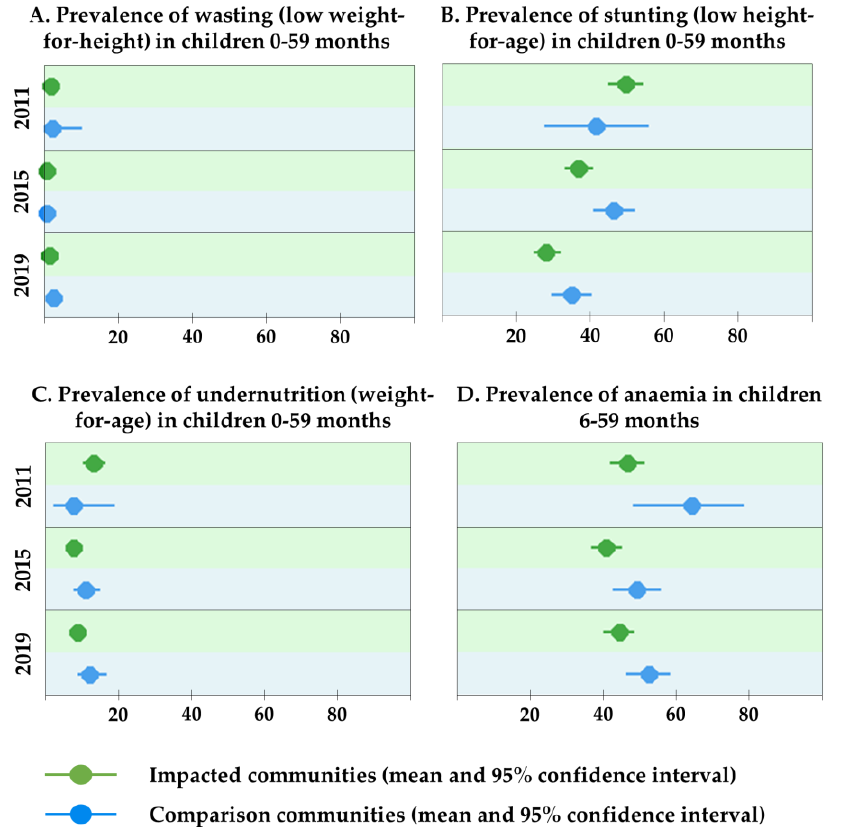
Figure 3. Nutritional indicators and anaemia, Trident project, Zambia (2011, 2015 and 2019).